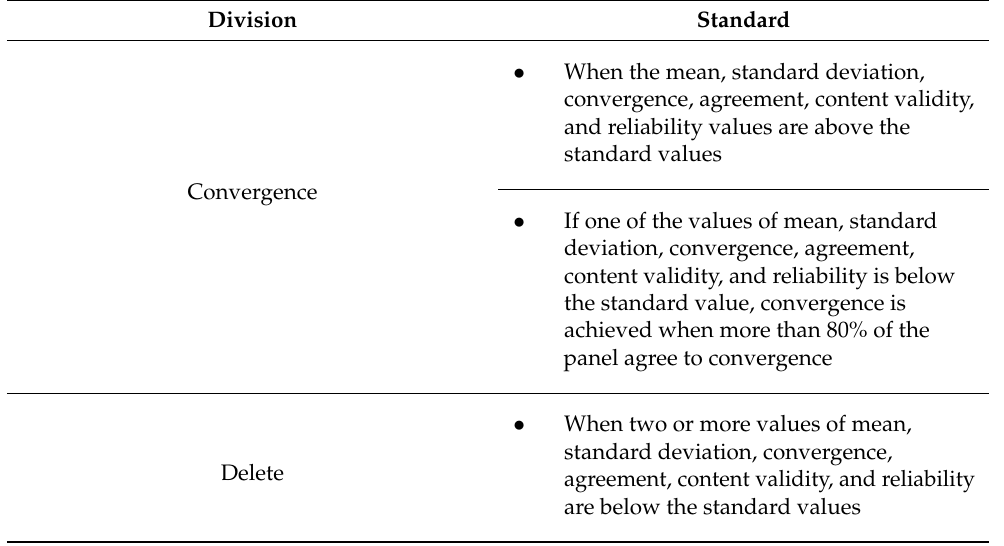
Table 2. Evaluation indicators for determining the sub-factors. Division Standard • When the mean, standard deviation, convergence, agreement, content validity, and reliability values are above the standard values Convergence • If one of the values of mean, standard deviation, convergence,